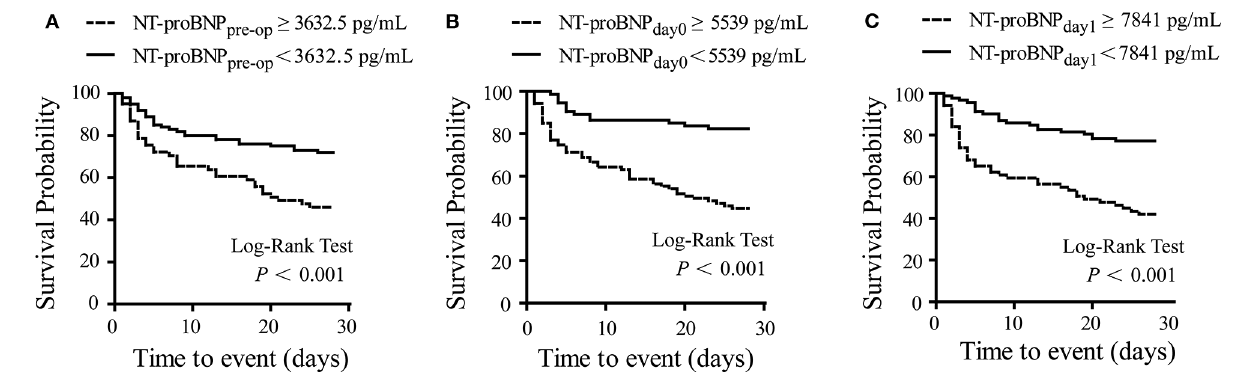
FIGURE 3 | Kaplan-Meier curve for survival. Survival probability in patients with low and high NT-proBNP levels. A significant difference was observed with higher risk of survival events in patients with NT-proBNP pre − op ≥ 3,632.5 pg/mL (A) , NT-proBNP day0 ≥ 5,539 pg/mL (B) , and NT-proBNP day1 ≥ 7,841 pg/mL (C) . Log-rank P -value shown on graphs. NT-proBNP pre − op , preoperative NT-proBNP level; NT-proBNP day0 , NT-proBNP level at RRT initiation; NT-proBNP day1 , NT-proBNP level on the first day after RRT initiation.